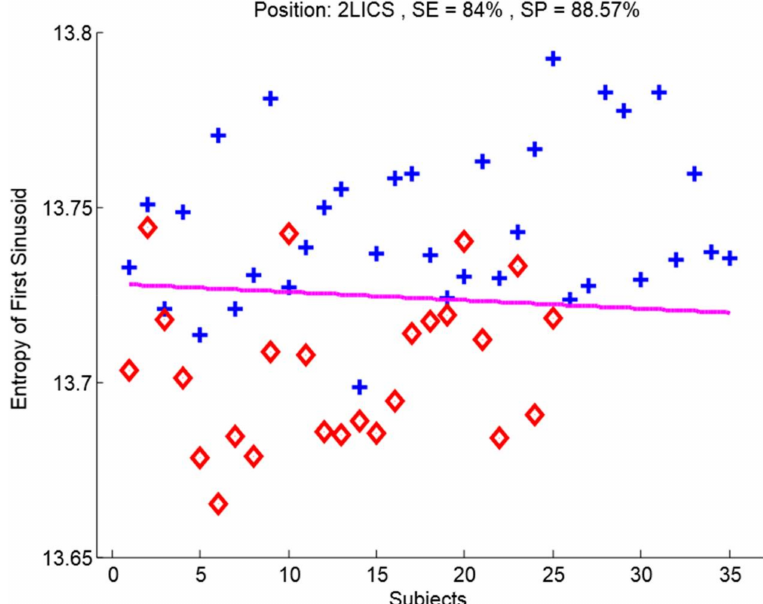
Figure 5. Classification of pulmonary artery hypertension. The entropy of the first sinusoid formant of heart sounds collected from the 2 nd left intercostal space site separated subjects with normal pulmonary artery pressure (blue crosses) from subjects with pulmonary artery hypertension (red diamonds). The pink line signifies the line of separation using linear discriminant analysis using the leave-one-out method. Abbreviations SE = Sensitivity, SP =